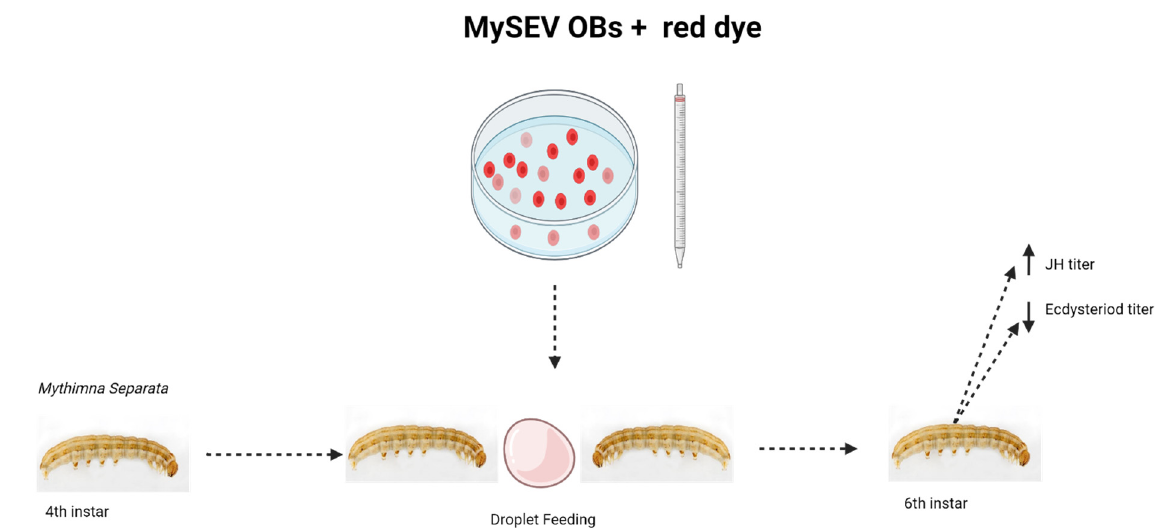
Figure 2. Regulation of endocrine hormones by the microbiota. The fourth instar of M. separata was inoculated with MySEV occlusion bodies, by the droplet feeding method. The results of liquid chromatography–MS analysis, against the sixth larval instar, revealed that the titer of juvenile hormone (JH) was significantly increased, whereas the titer of ecdysteroids was significantly decreased in the hemolymph of infected